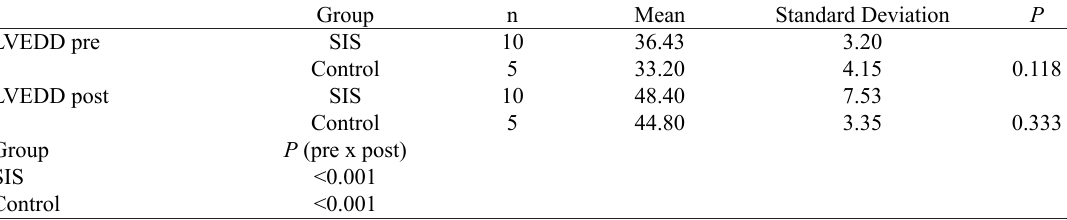
Table 4. Inter- and intra-group left ventricular end diastolic diameter analysis (mm) between pre-operative evaluation and 60 days after